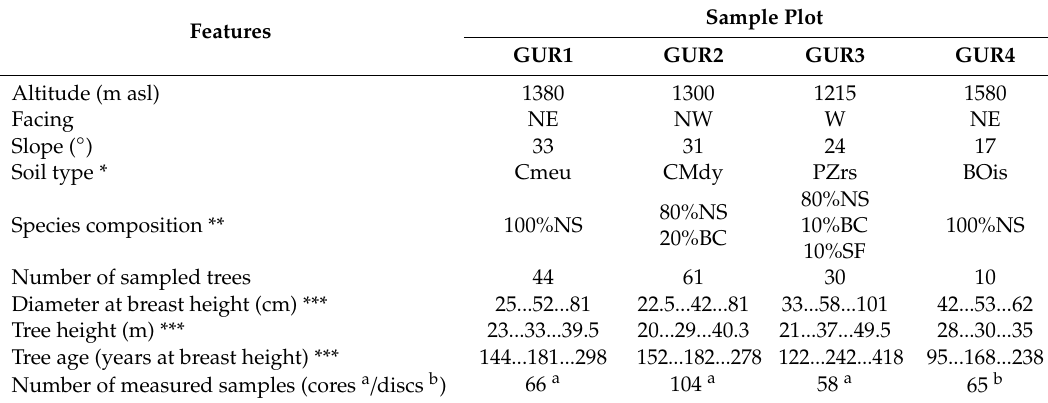
Table 1. Summary of sampled